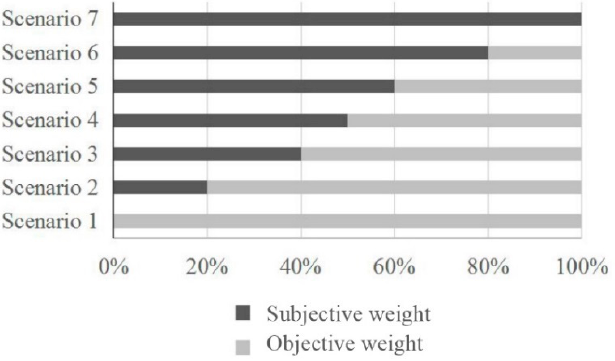
Figure 5. Integrated weight information.